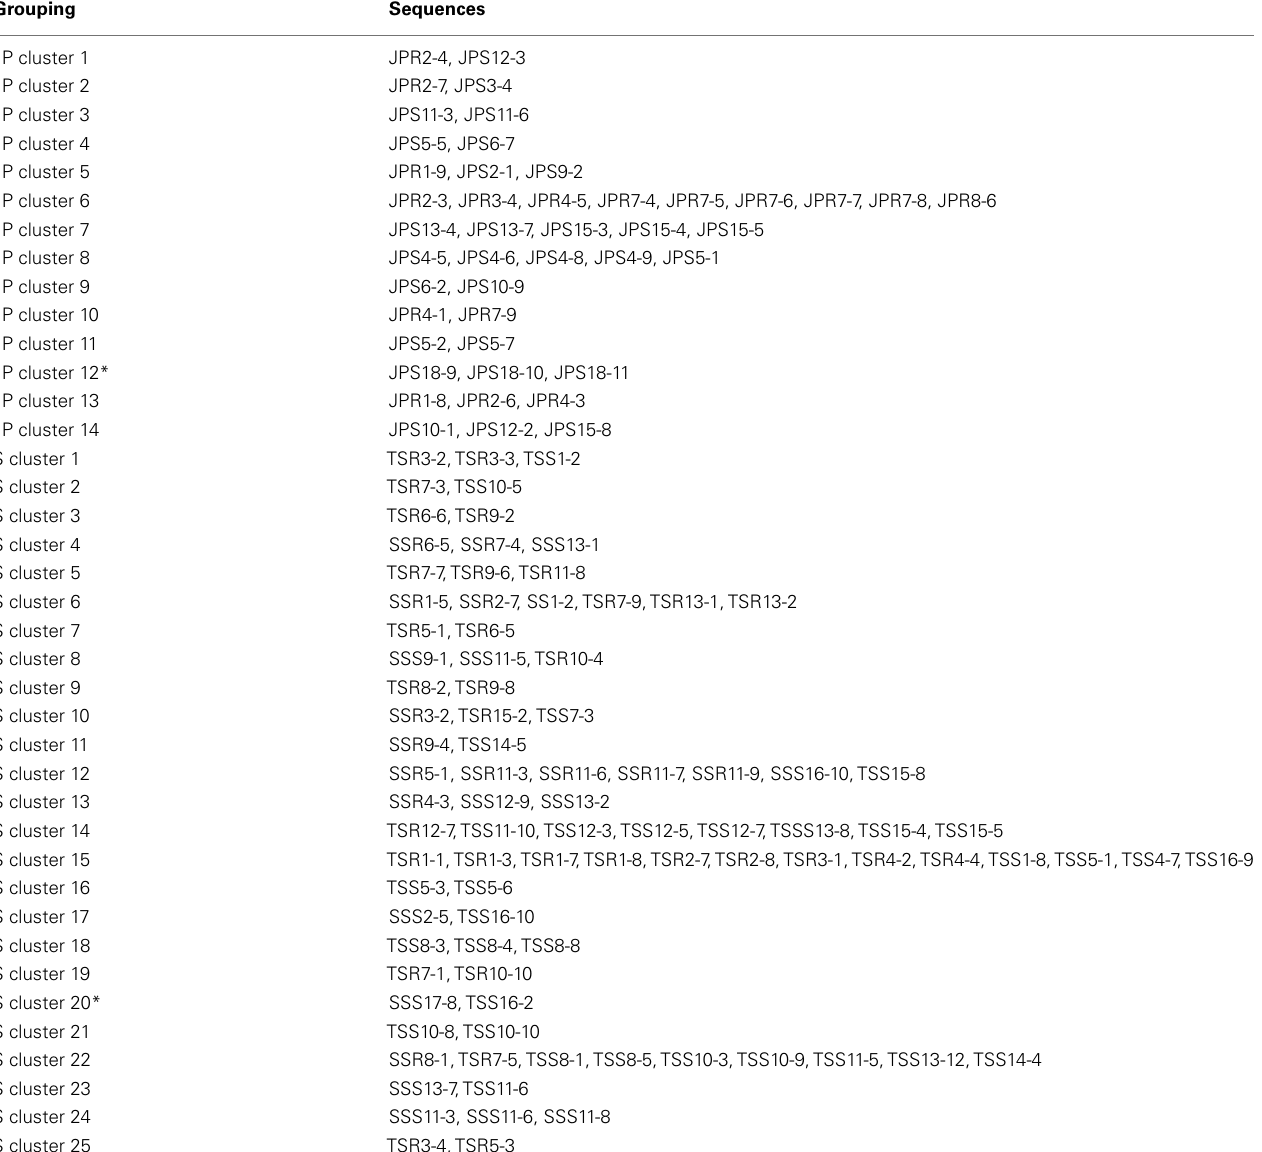
TableA4 | Sequences included in the plant host clusters designated in Figures 6 and 7 (* α - Proteobacteria